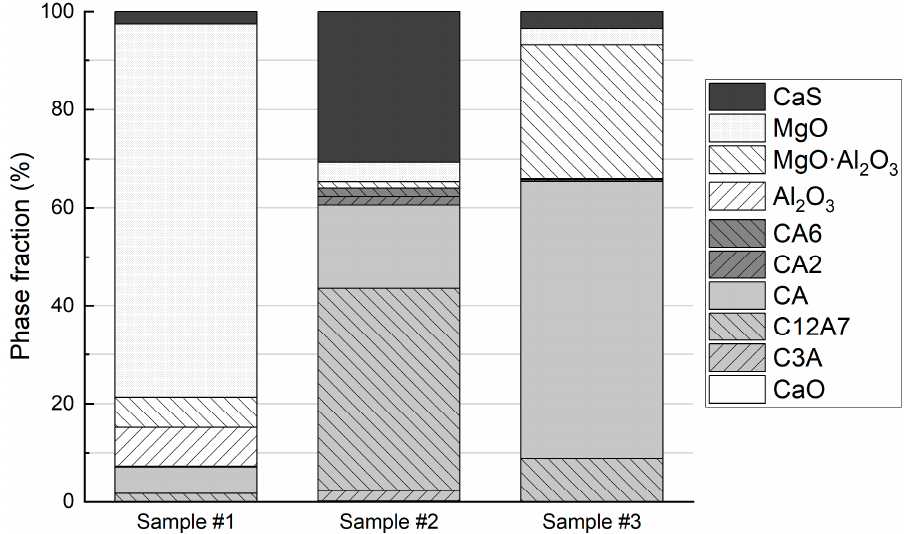
Figure 7. NMI phase fractions in the steel samples.